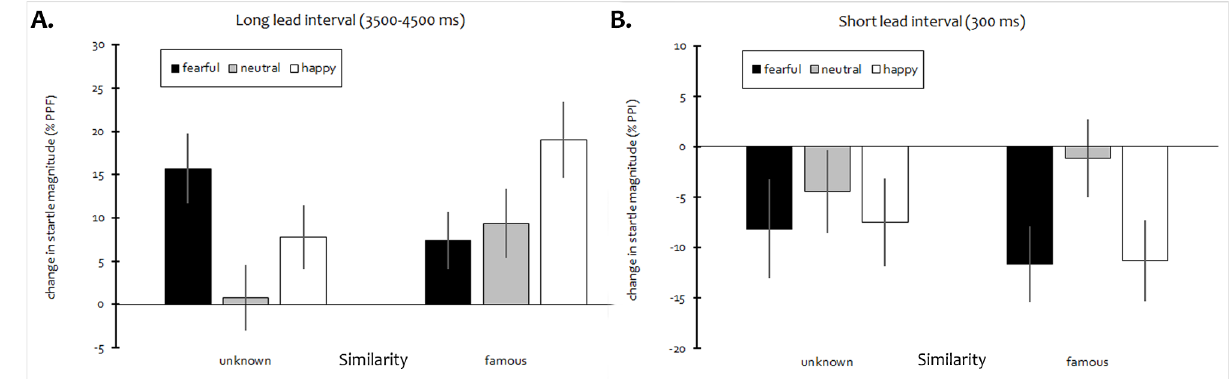
Fig 4. Mean proportional change in startle magnitude during presentation of morphed faces with different emotional expressions as a function of facial resemblance(famous vs. unknown). A. long lead interval (3500–4500ms, PPF), B. short lead interval (300 ms, PPI). Error bars represent